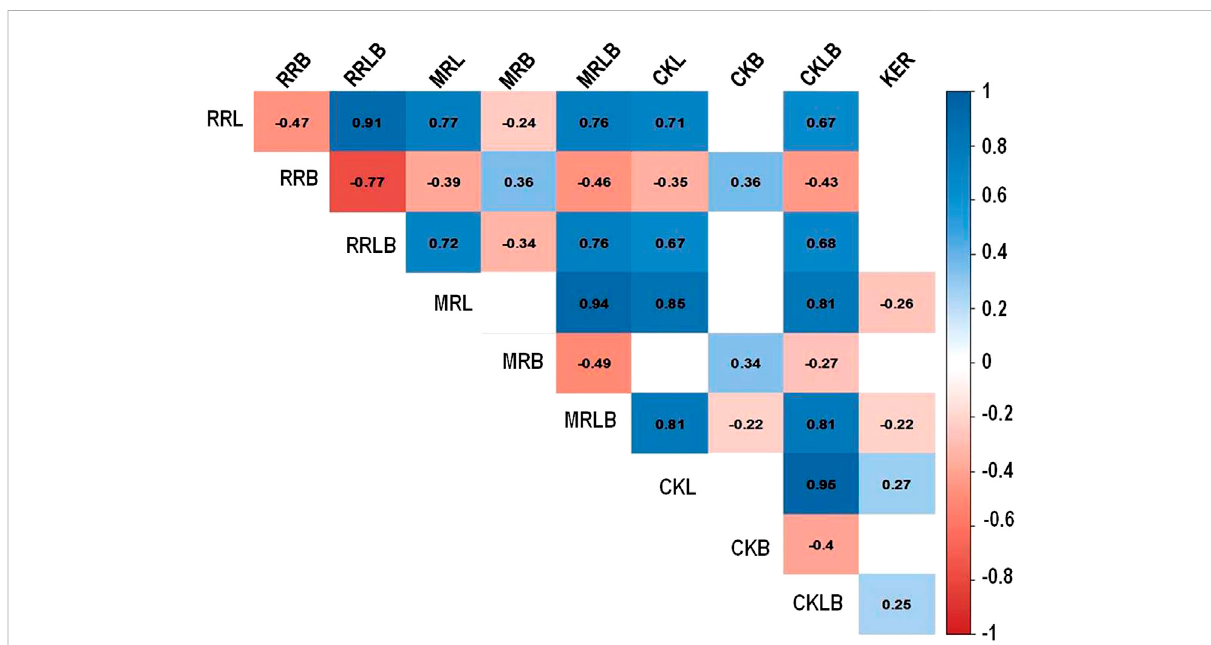
FIGURE 3 Correlation among grain dimension traits in rice. Rough rice length (RRL), rough rice breadth (RRB), rough rice length to breadth ratio (RRLB), milled rice length (MRL), milled rice breadth (MRB), milled rice length to breadth ratio (MRLB), cooked kernel length (CKL), cooked kernel breadth (CKB), cooked kernel length to breadth ratio (CKLB), and kernel elongation ratio (KER).